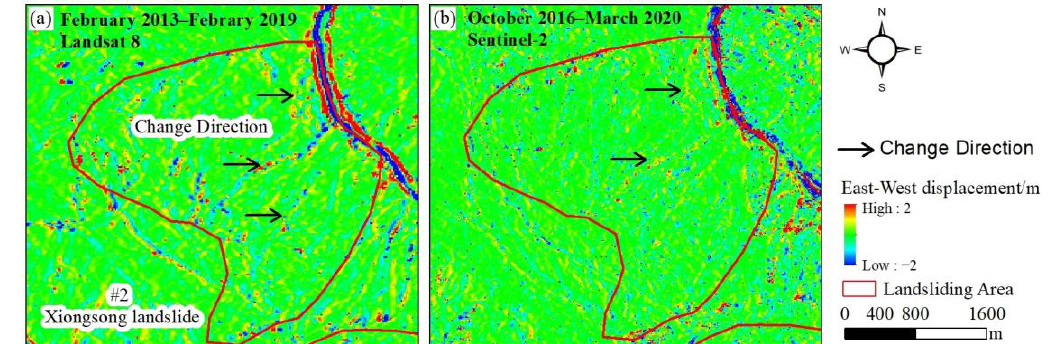
Figure 10. Changes in the Xiongsong landslide revealed by COSI-Corr method. The red and blue regions represent the eastward and westward movement. a) Changes detected using Landsat 8 images; b) Changes detected using Sentinel-2 images.